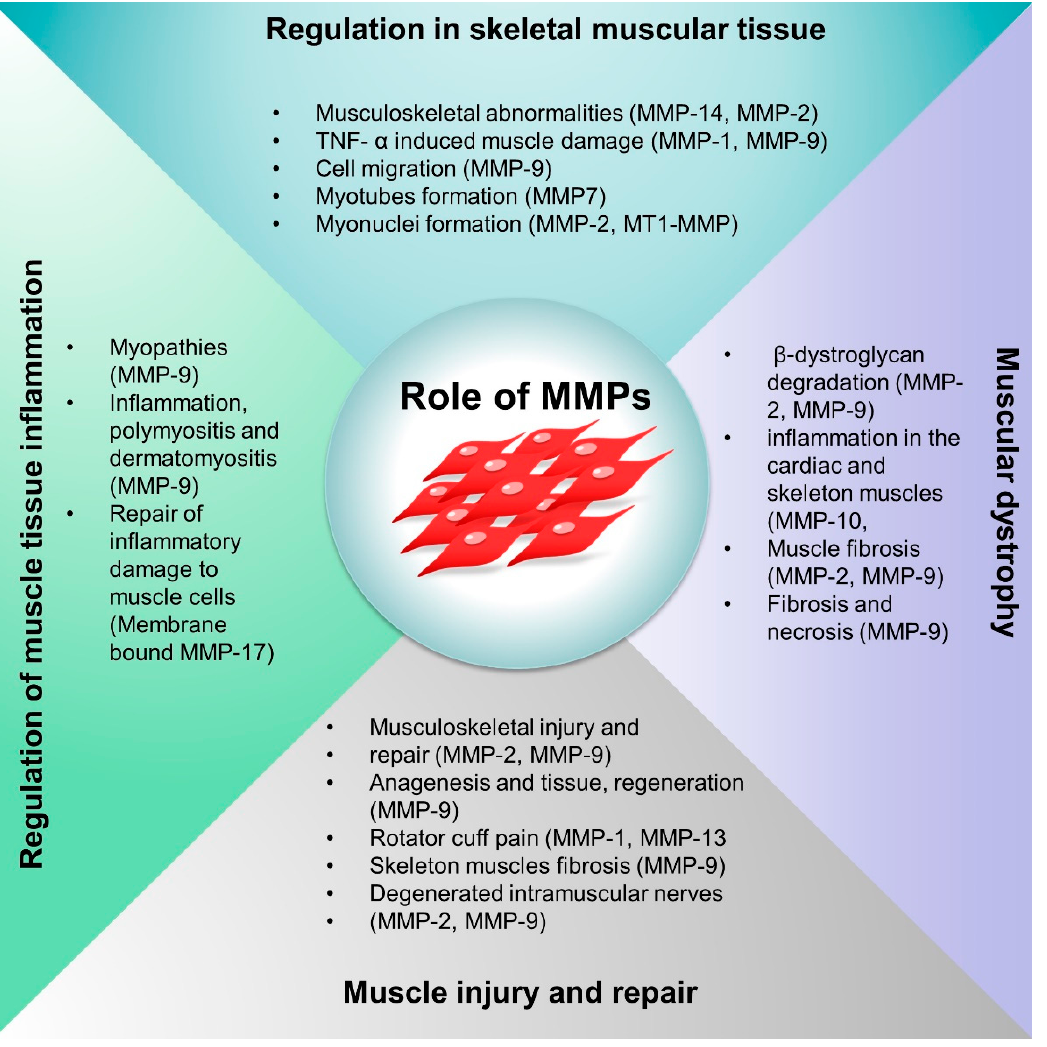
Figure 4. Schematic representation of the roles of MMPs in skeletal muscle regulation, muscle injury and repair, inflammation and oxidative stress, and muscular dystrophy.